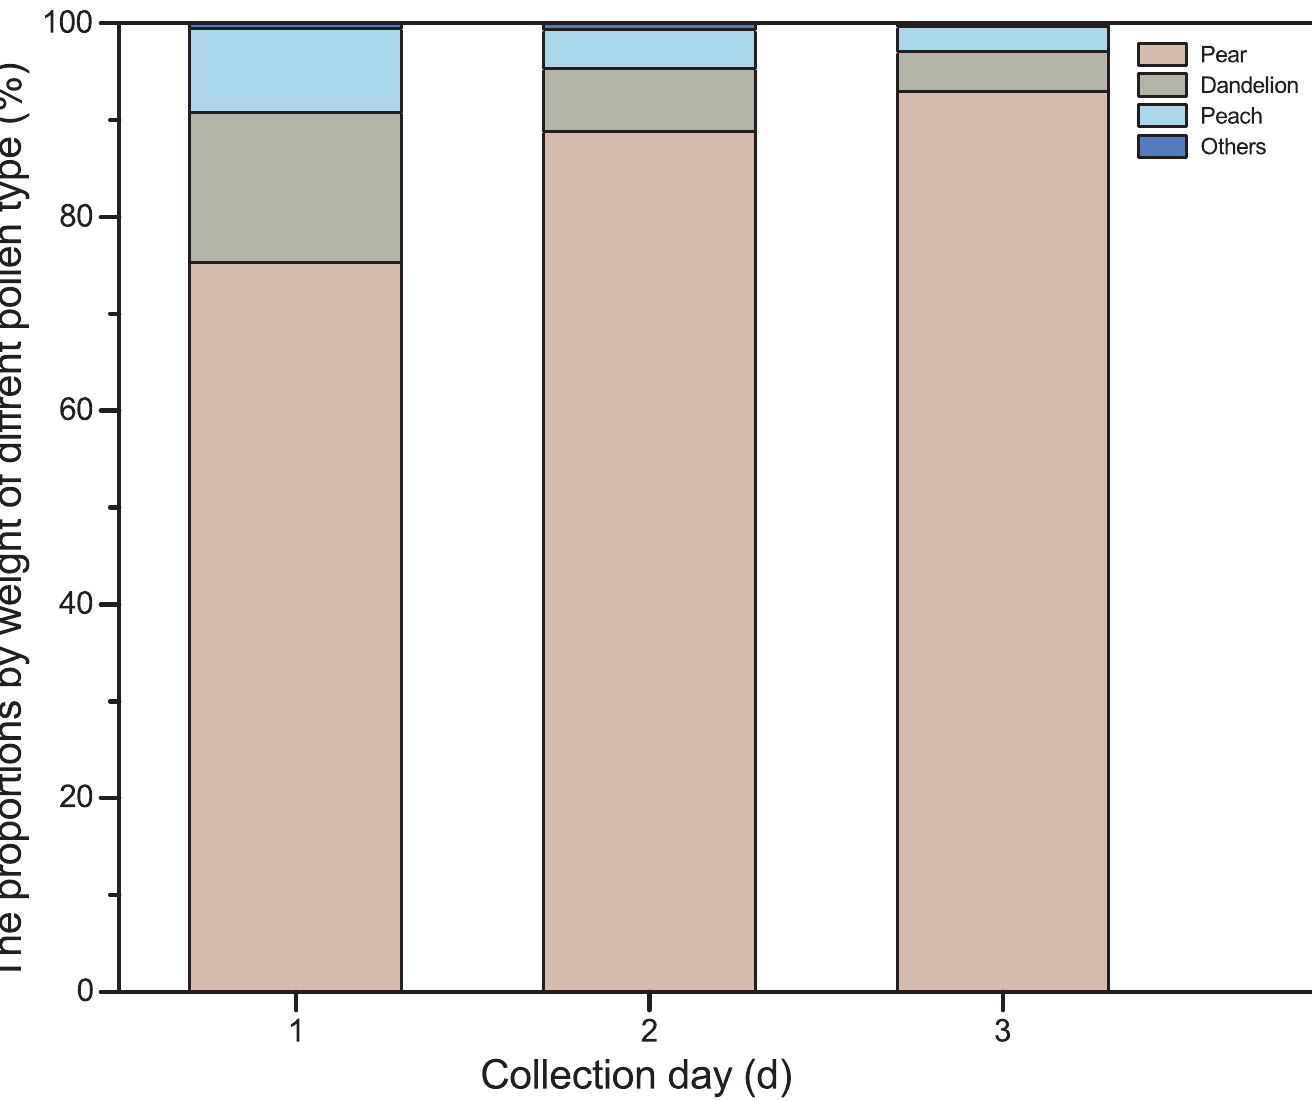
Fig 6. The proportions of different pollen types for day 1, day 2 and day 3. Pollen proportions for pear, peach and dandelion species were plotted on the bars. The bars show that the proportion of pollens from pear increases with days whereas the proportion of pollens from peach and dandelion decreases with days.